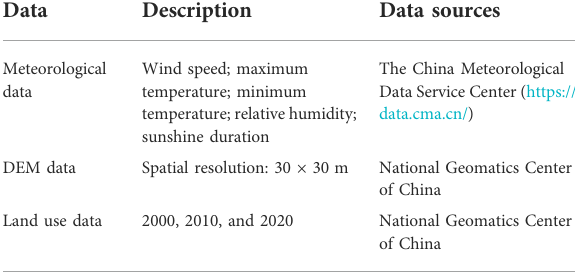
TABLE 1 The sources and description of